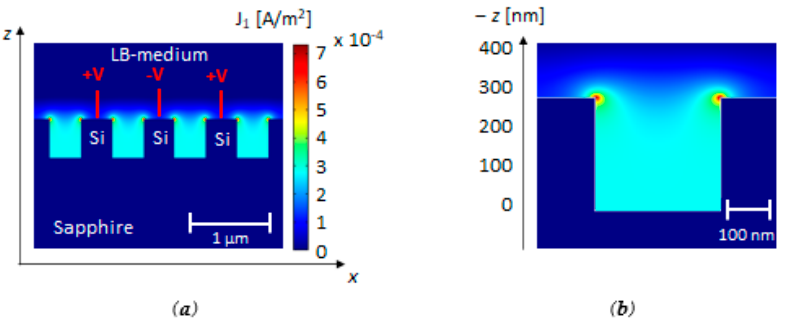
Figure 4. ( a ) Current density J 1 [A/m 2 ] distribution along the x -axis in the middle of the INEs structure with f 1 = 100 Hz, V 0 = 10 mV, Λ n = 440 nm, and FF = 0.5; ( b ) Focus at the surface of the electrodes with the energy confinement in few hundreds of nanometers. Plots calculated by 2D FEM approach.